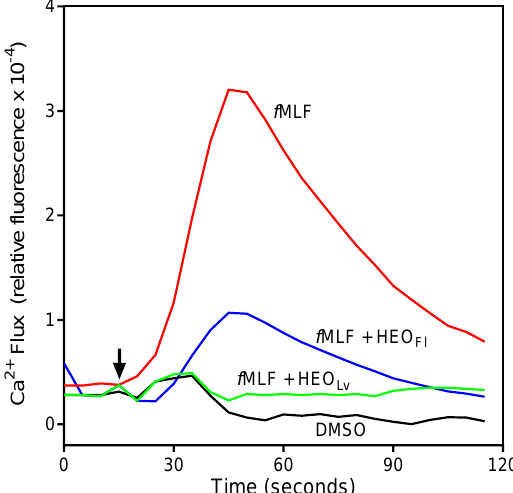
Figure 2. Effect of HEO Lv and HEO Fl on f MLF-induced Ca 2+ mobilization in human neutrophils. Human neutrophils were pretreated for 10 min with 25 µg/mL of the indicated essential oil or 1% DMSO (negative control), followed by stimulation with 5 nM f MLF (indicated by arrow), and Ca 2+ flux was monitored for the indicated times. The data are from one experiment that is representative of three independent experiments.